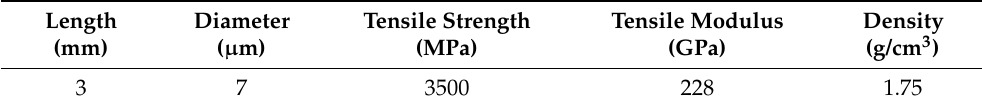
Table 3. Physical properties of carbon fiber.